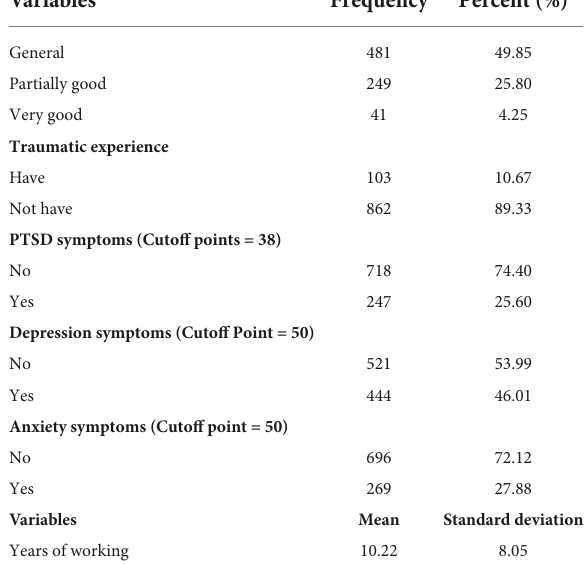
TABLE 1 Demographic characteristics of healthcare professionals in China ( N =